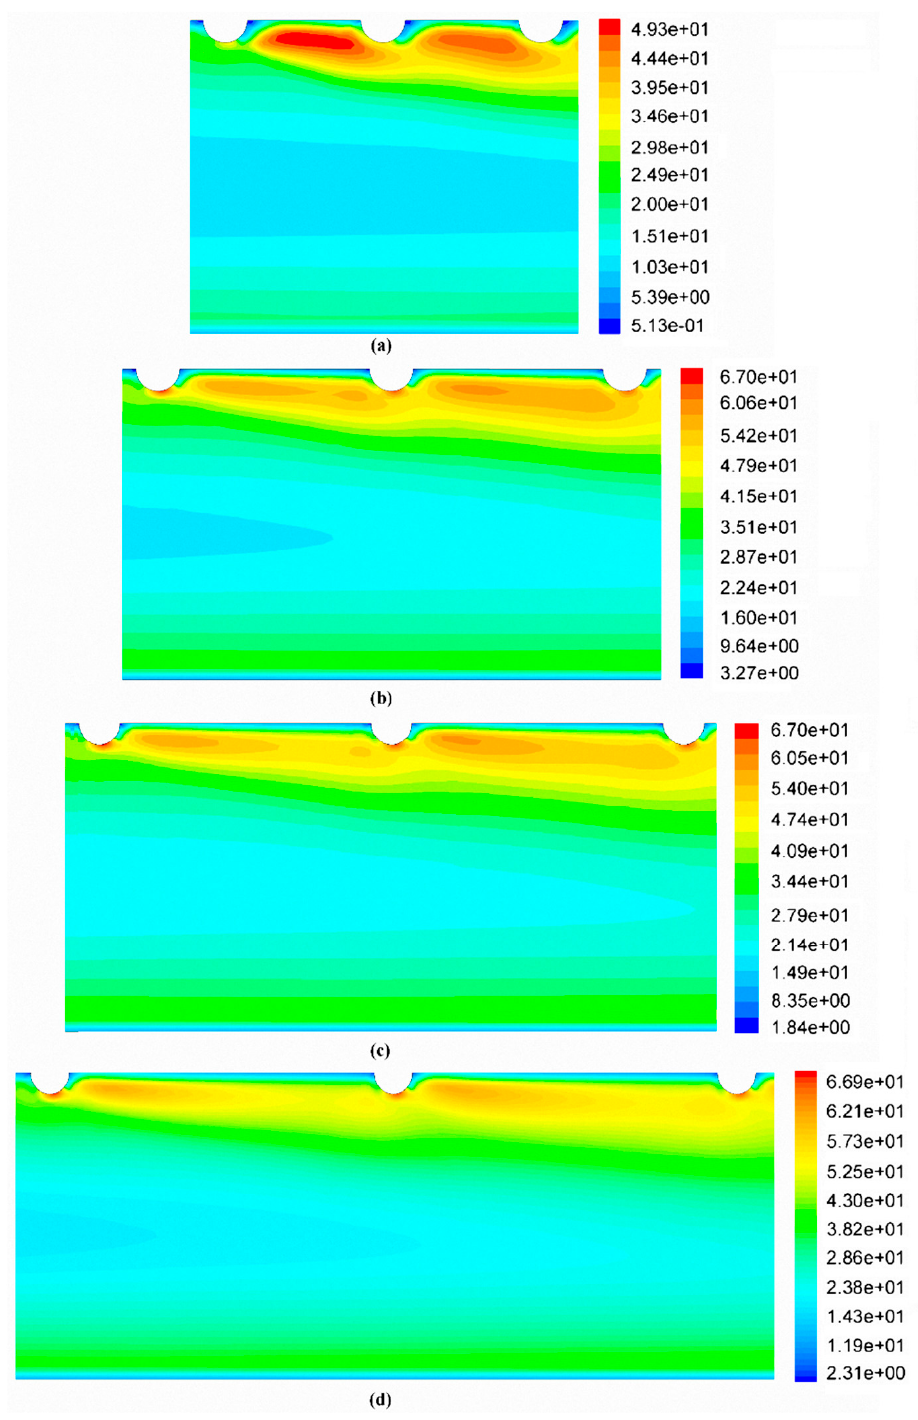
Figure 8. A contour plot of TI for RRH = 0.045 at Re = 8000 for: ( a ) RRP = 6.67, ( b ) RRP = 10, ( c ) RRP = 13.33 and ( d ) RRP = 16.67.